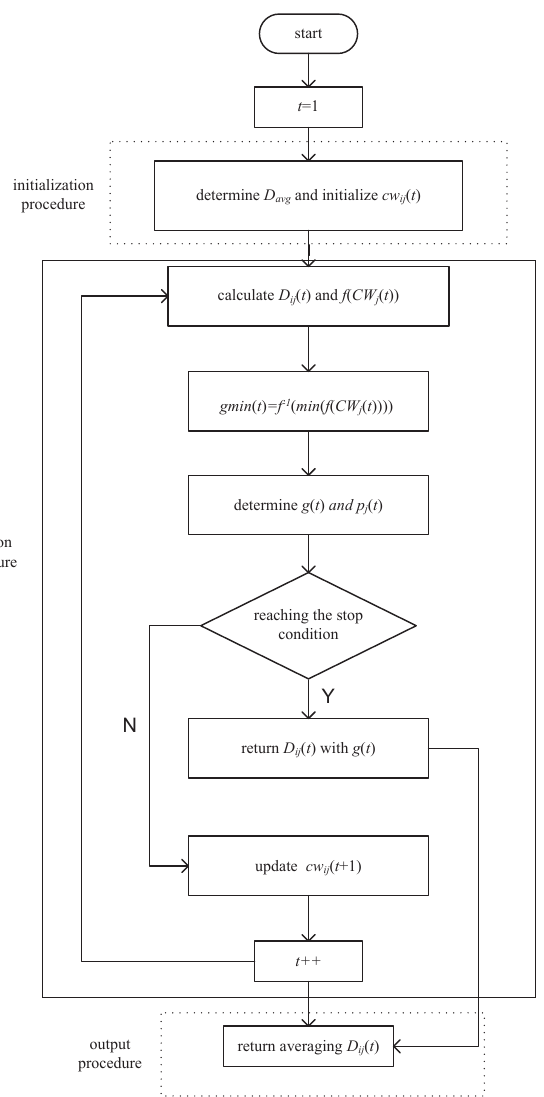
Figure 3. The flow chart of the swarming